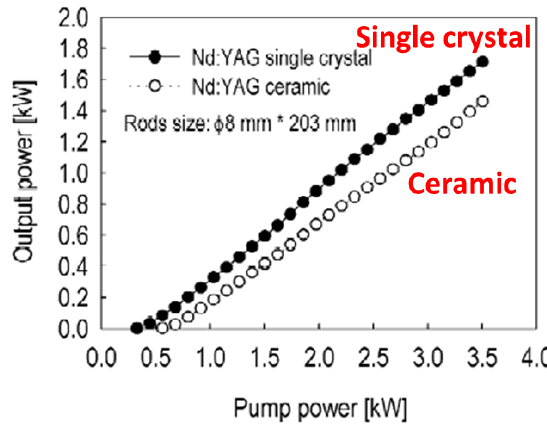
Figure 8. Results for first Nd:YAG laser to break 1 KW output power (Adapted from